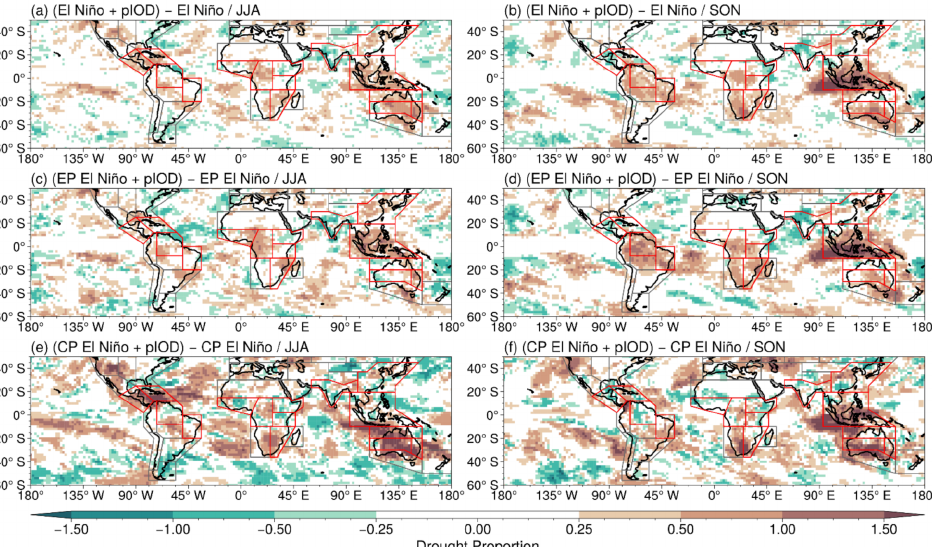
Figure 8. The drought proportion in Jun-Jul-Aug (JJA) and Sep-Oct-Nov (SON) when combined El Niño and pIOD occur. ( a , b ) is for El Nino, ( c , d ) is for EP El Nino, and ( e , f ) is for CP El Nino. (El Niño + pIOD) − El Niño represents the difference between the drought proportion when com- bined events occur and the proportion when only El Niño events occur. The land regions with red edges are easily affected by El Niño.